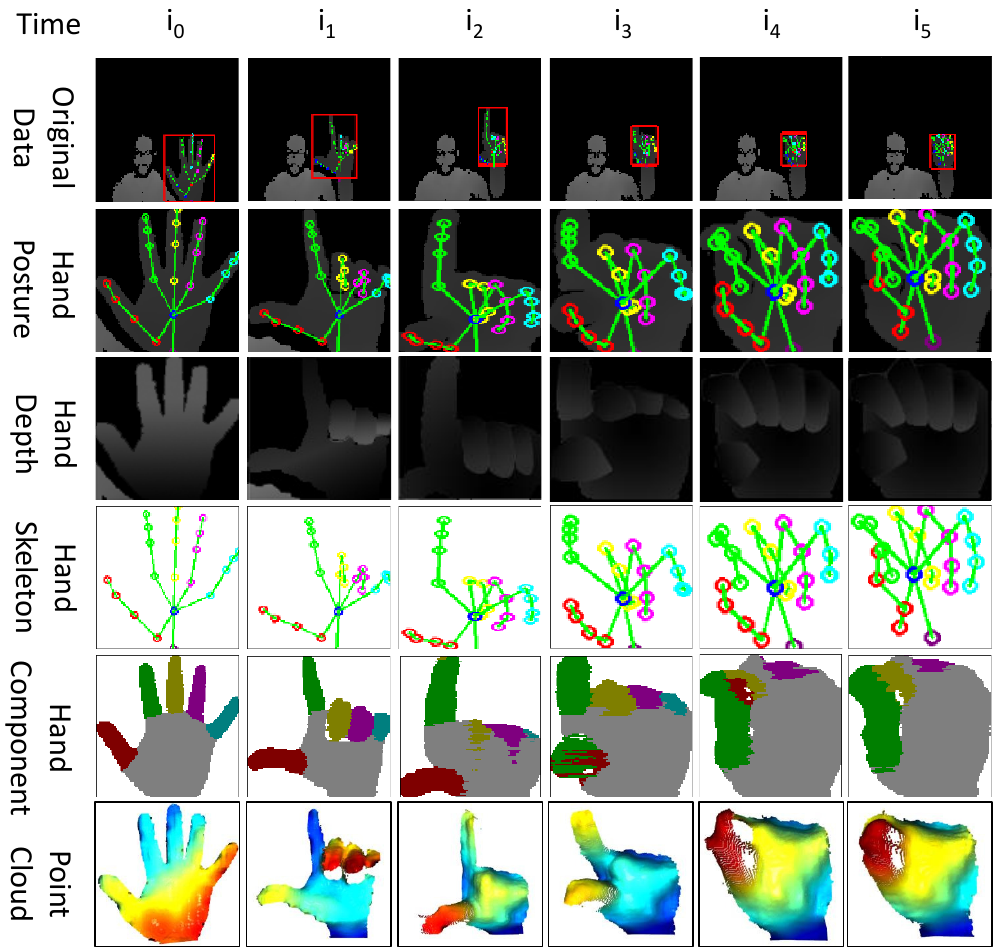
Figure 1. Overview of the features of a dynamic hand gesture. Left to right shows the time axis of the gesture, and top to bottom shows the types of hand data features, consisting of the original data, hand posture, hand depth, hand skeleton, hand component, and hand